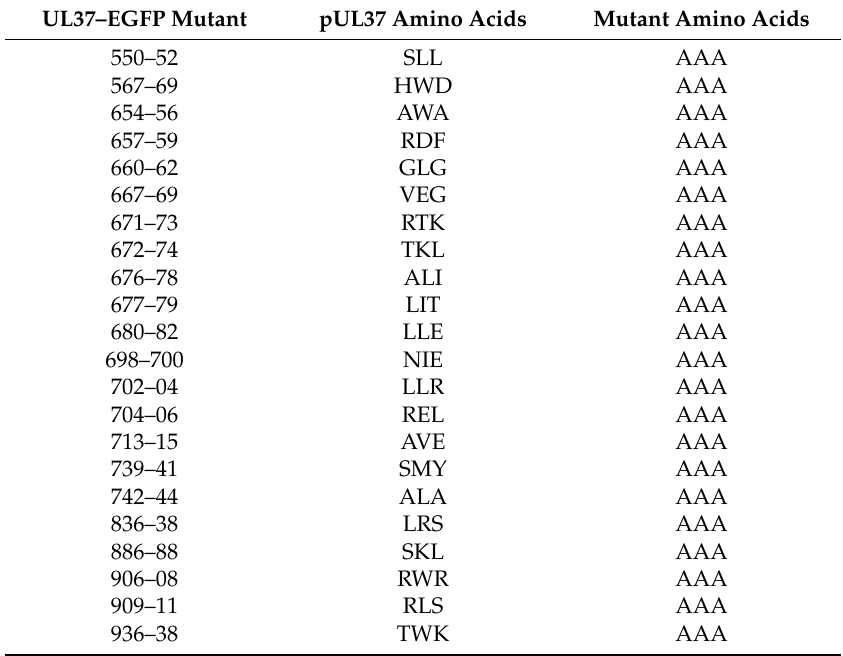
Table 2. UL37–EGFP triple alanine (AAA) scanning